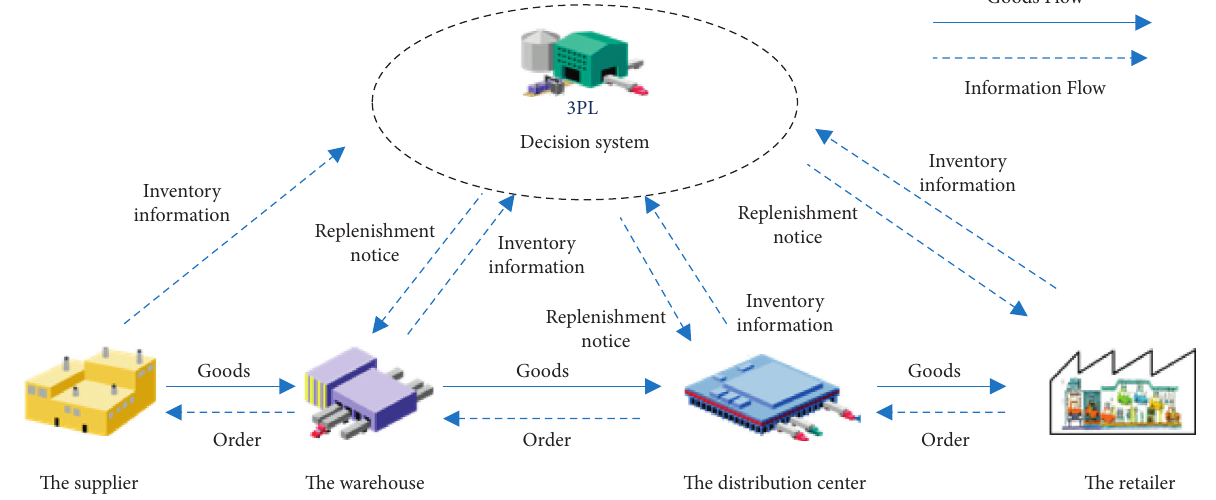
Figure 1: The TMI-SC operation flowchart.